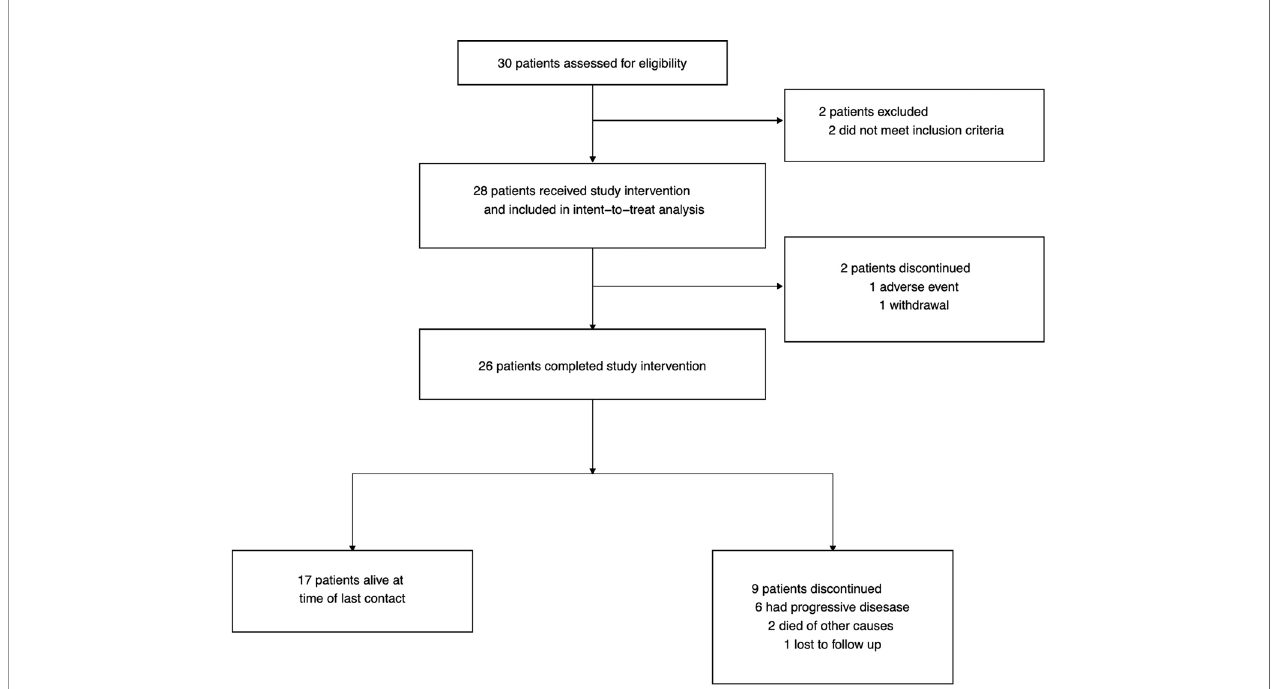
FIGURE 1 | CONSORT